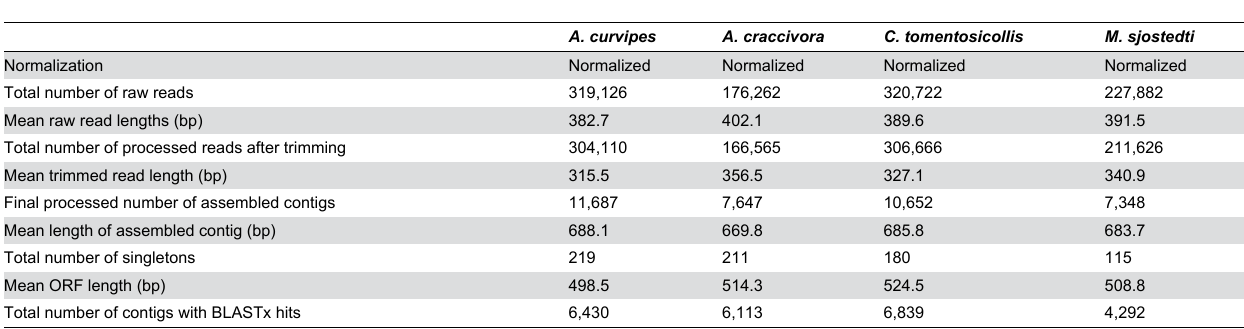
Table 3. Summary of the putative single nucleotide polymorphism (SNP) predictions from reads mapped to reference A. curvipes , A. craccivora , C. tomentosicollis and M. sjostedti